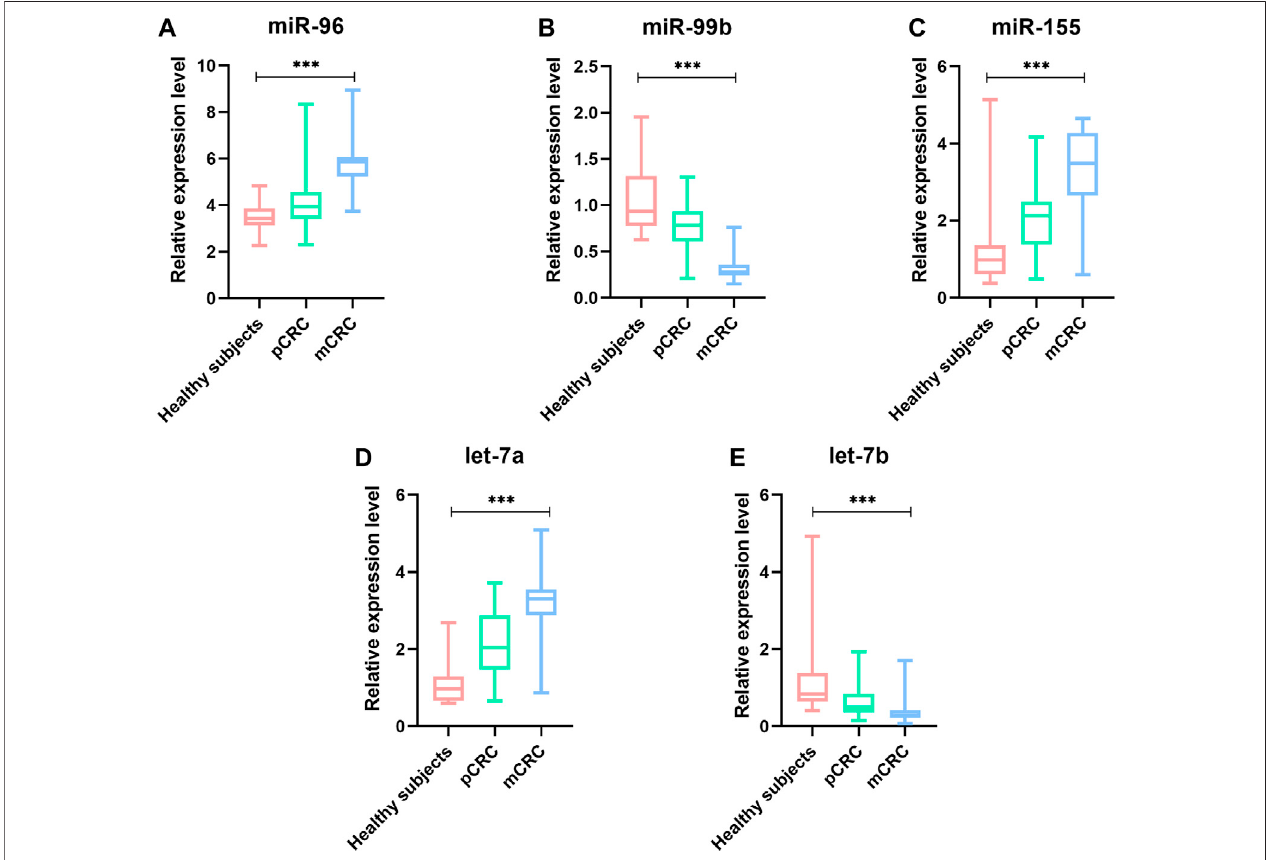
FIGURE4| TherelativeexpressionlevelofmiRNAsinplasmasamples(41pCRC,49mCRCand20controls). (A) miR-96; (B) miR-99b; (C) miR-155; (D) Let-7a; (E) Let-7b; * p value ＜ 0.05, *** means p value ＜ 0.001.